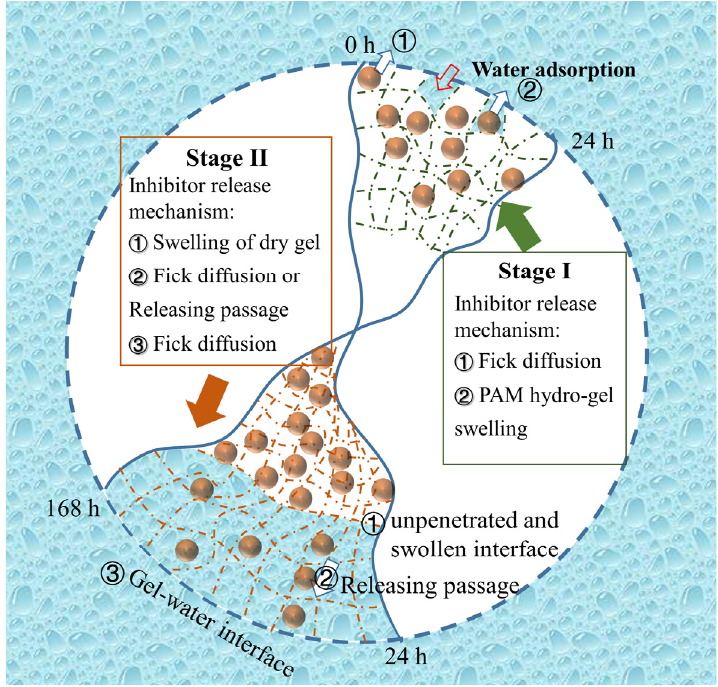
Figure 7. schematic of two releasing stages of the inhibitor from OIM@PAM. Figure 7. Schematic of two releasing stages of the inhibitor from OIM@PAM